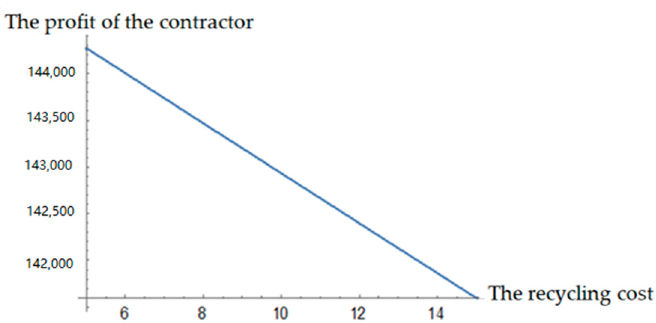
Figure 2. Effects of recycling cost on the contractor’s profit.